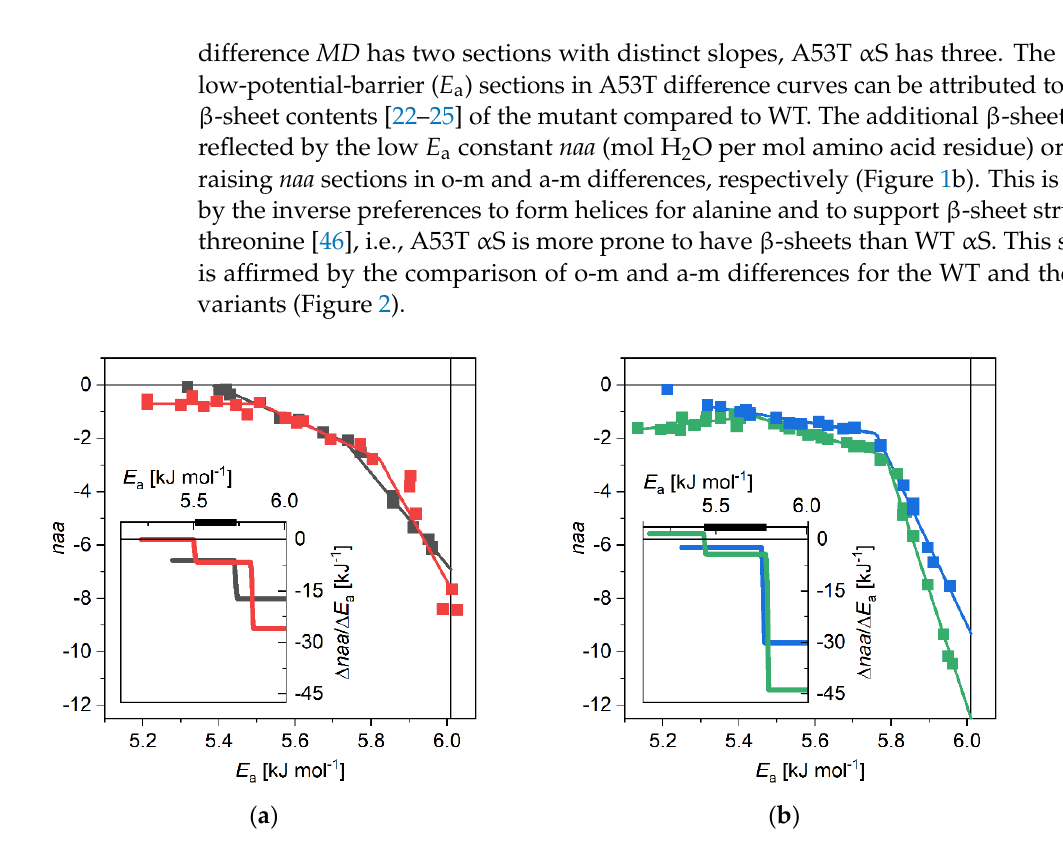
Figure 2. ( a ) Oligomer-monomer melting diagrams for wild type (grey) and A53T (red) α-synuclein; ( b ) Amyloid-monomer melting diagrams for wild type (blue) and A53T (green) α-synuclein. Mol H 2 O per mol amino acid residue ( naa ) vs. potential barrier. Lines are guides to the eye. The insets are the derivative forms of the difference melting diagrams. The thick black lines denote the common sections on the derivative melting diagrams.